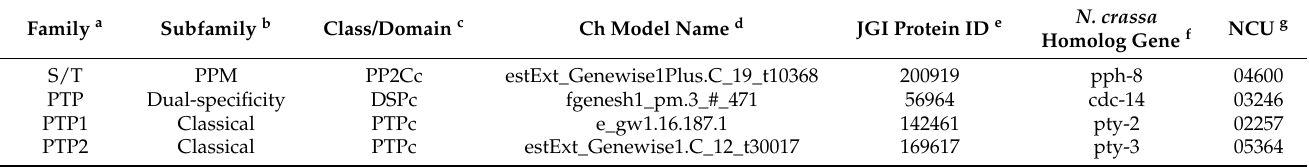
Table 2. Candidate protein phosphatase gene